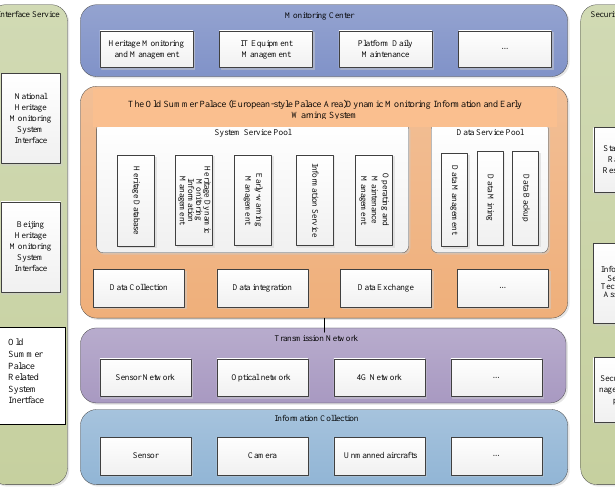
Figure 3. Overall Structure of the Monitoring